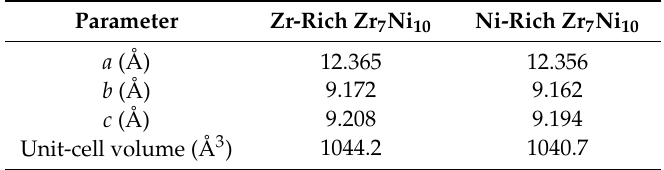
Table 7. Experimental lattice parameters for Zr-rich and Ni-rich Zr 7 Ni 10